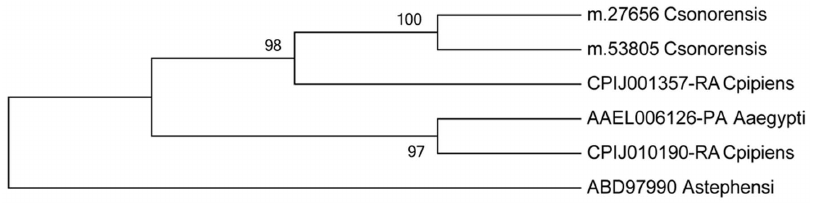
Figure 10. Maximum likelihood tree for Culicoidessonorensis and mosquito vitellogenins. Consensus tree for full protein sequence of vitellogenins is shown for Culicoides sonorensis (including unigene number) and mosquitoes (including Genbank accession numbers). The percentage of replicate trees in which the associated taxa clustered together in the bootstrap test (1000 replicates) are shown next to the branches Evolutionary analyses were conducted in Mega5 (www.megasoftware.net). ClustalW alignment used for generating this tree is available in Fig. S2.